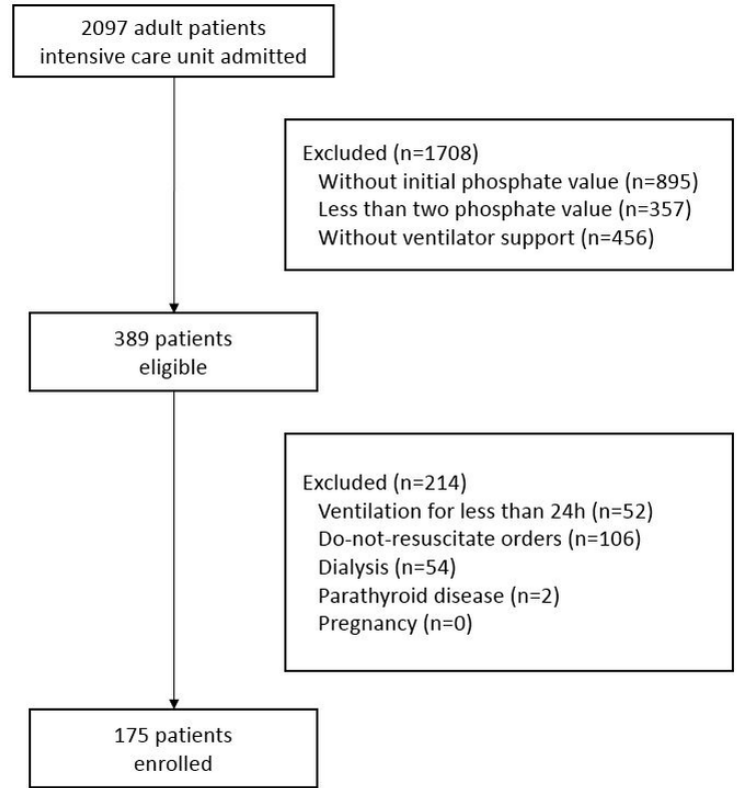
Figure 1. The flow chart of patient registration. Table 1. Baseline patient medical and demographic characteristics ( n = 175).